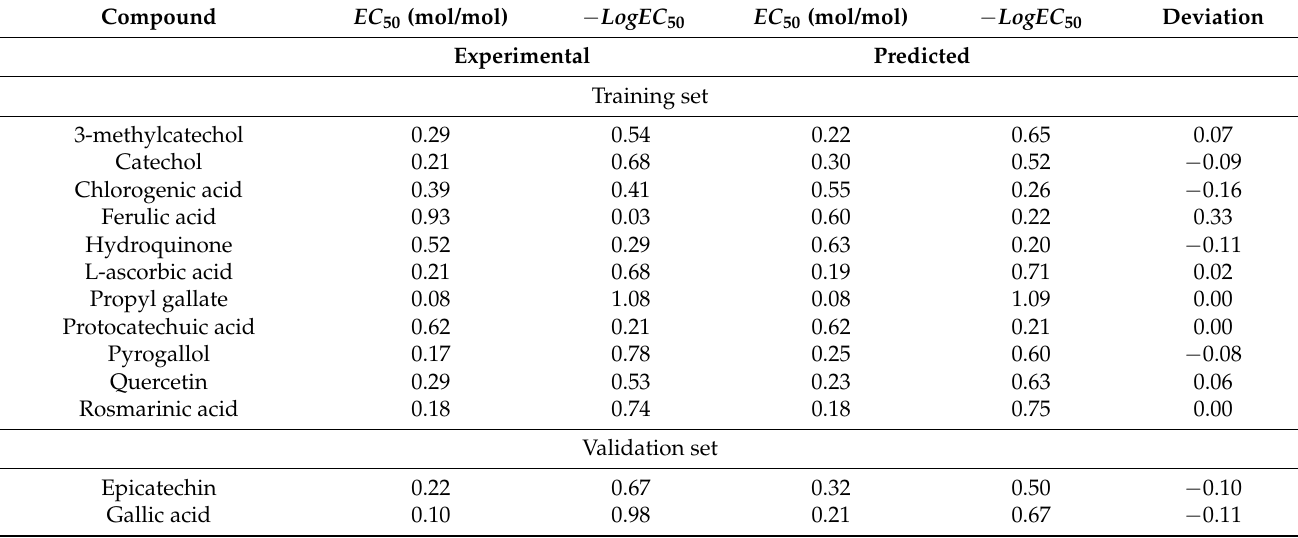
Table 4. Experimental and predicted values of EC 50 and their logarithms for each compound used in QSAR model with 4